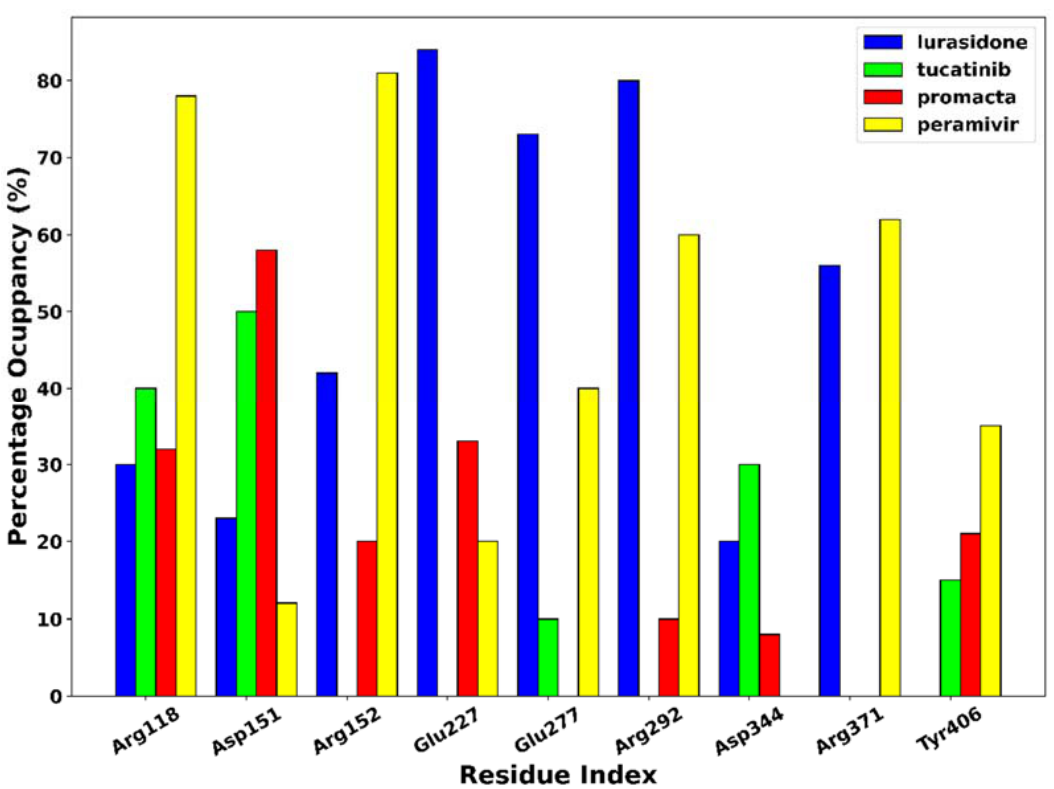
Figure 8. Hydrogen bond occupancy of NA–ligand complexes during 250 ns simulations.